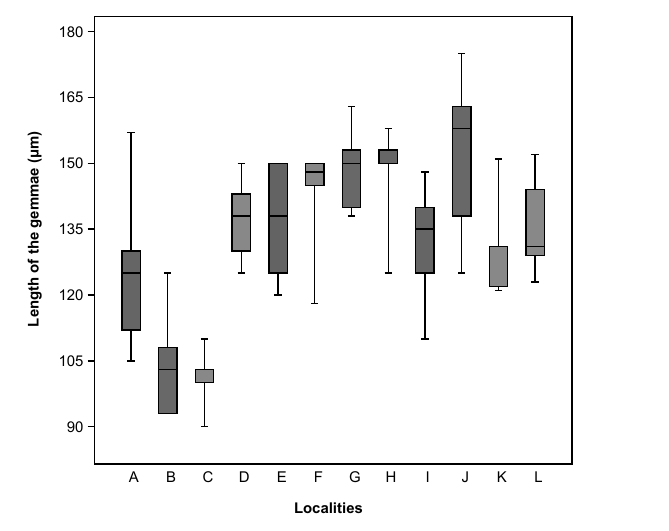
Figure 5 Box and whisker plot of gemmae length of Bryum gemmiferum studied in 12 localities in Poland. Box – first and third quartile with a median; whiskers – minimum and maximum value. ( A ) Wiąg; ( B ) Włocławek; ( C ) Dobrzyń nad Wisłą; ( D ) Losy; ( E ) Wyszogród; ( F ) Starczewice; ( G ) Drażniew; ( H ) Stary Sącz; ( I ) Huba; ( J )